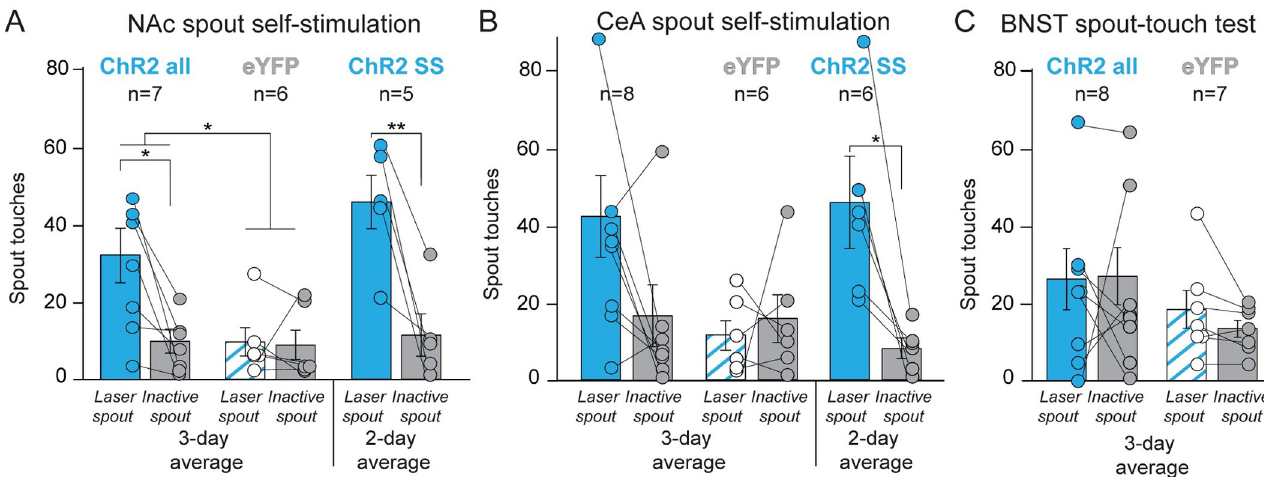
Fig 7. Laser self-stimulation of CRF-containing neurons in NAc and CeA, but not BNST. A) ChR2 rats could self-stimulate laser to excite CRF-containing neurons by touching a designated Laser spout to earn 3sec illuminations, whereas touching an Inactive spout delivered nothing. NAc ChR2 rats as an entire group demonstrated significant self-stimulation across all 3 days of testing (n = 7). NAc ChR2 individuals that met criteria for laser self-stimulation on day 1 (n = 5, ChR2 SS) continued to self-stimulate on days 2–3 by touching their Laser-spout > 400% more than the Inactive-spout . B) CeA ChR2 rats as an entire group showed only a nonsignificant trend toward laser self-stimulation (n = 8). However, CeA ChR2 individuals that met self-stimulation criteria on day 1 (n = 6; ChR2 SS) continued to self-stimulate on days 2–3. touching their Laser-spout 400% more than the Inactive-spout . By contrast, control NAc eYFP (n = 6) and CeA eYFP rats (n = 6) failed to self-stimulate, and merely touched randomly at low rates. C) BNST ChR2 rats failed as a group to self-stimulate for laser excitation of CRF-containing neurons (n = 8) across all 3 test days, similar to eYFP controls (n = 7). No BNST ChR2 individuals met criteria for self-stimulation on any day. Means and SEM reported. � p < 0.05, �� p <